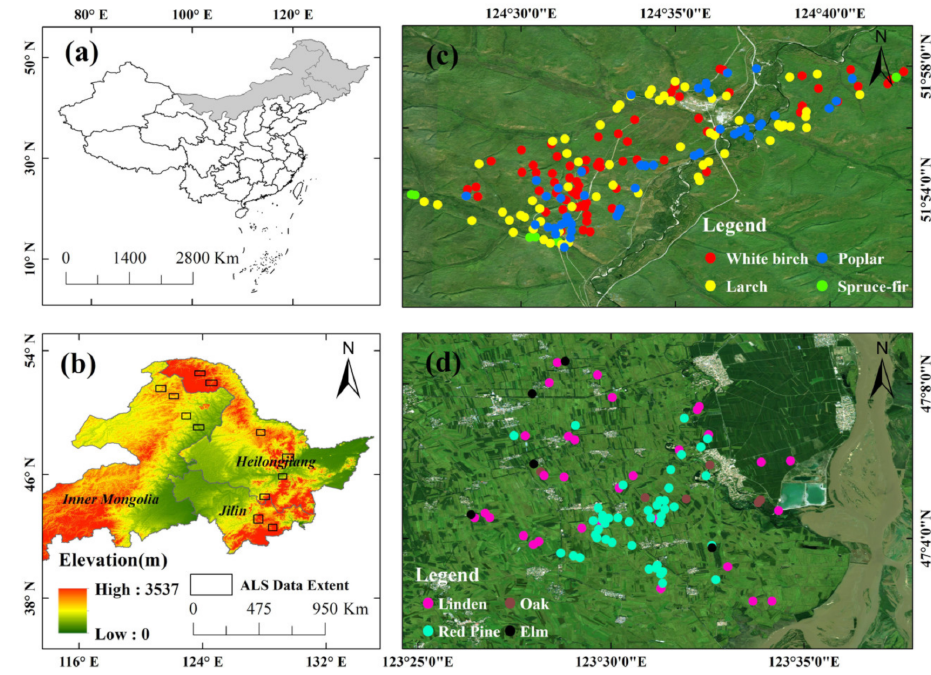
Figure 1. ( a ) Location of the Heilongjiang, Jilin and Inner Mongolia three provinces in China. ( b ) Location of the study area with 12 ALS data areas highlighted in black. ( c , d ) Field plots’ distribu- tion in two ALS data